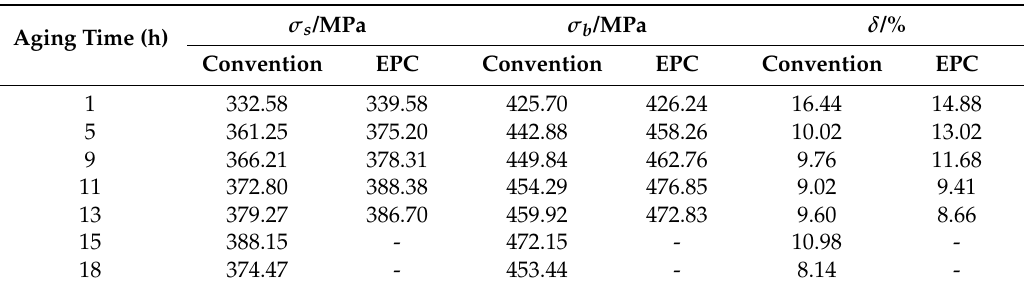
Table 4. Comparison of properties after stress relaxation aging with or without electric pulse under different aging